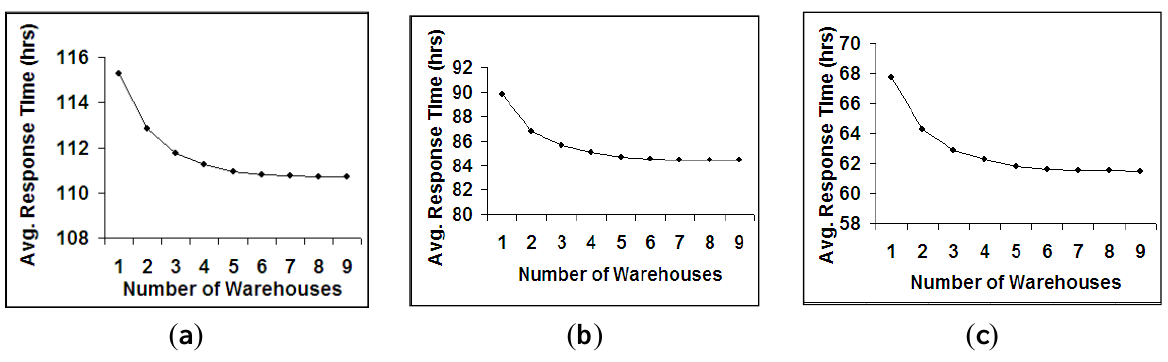
Figure 1. Average Response Time under Low, Medium, and High Inventory Levels for 1977–1986 Time Period. ( a ) Low Inventory Level; ( b ) Medium Inventory Level; ( c ) High Inventory